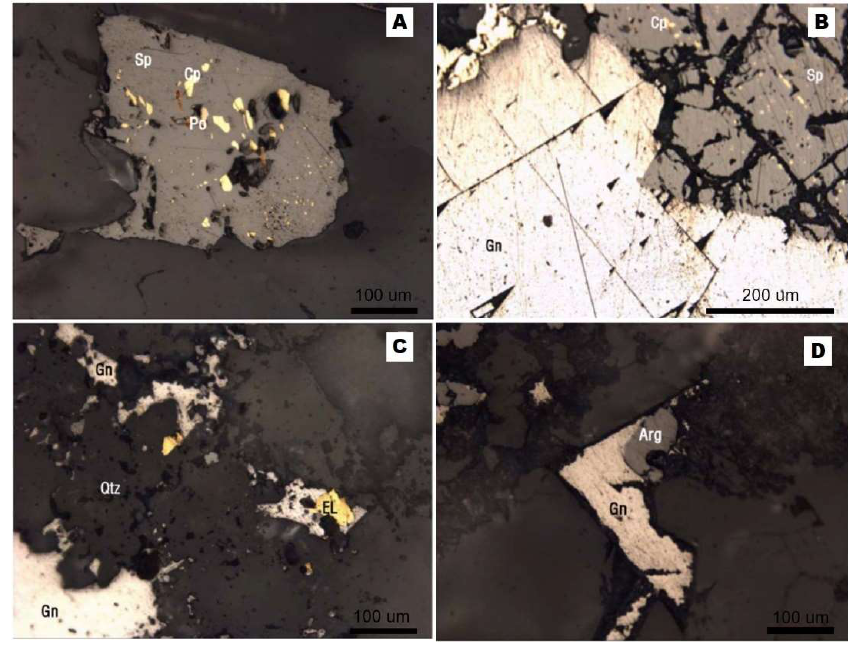
Figure 8. Reflected photomicrographs of ore specimens from the Eunjeok deposit. ( A ) Pyrrhotite bleb and chalcopyrite disease in sphalerite; ( B ) Galena with chalcopyrite disease in sphalerite; ( C ) electrum coexisting with galena infilling the quartz vein fracture; ( D ) infilling of the quartz vein by argentite and galena. Abbreviations: Arg = argentite, Cp = chalcopyrite, EL = elctrum, Gn = galena, Sp = sphalerite, po = pyrrhotite, Qtz = quartz. Table 4. FeS mole% of stage II sphalerites by EPMA analyses from the Eunjeok Au–Ag deposit. Sample No.